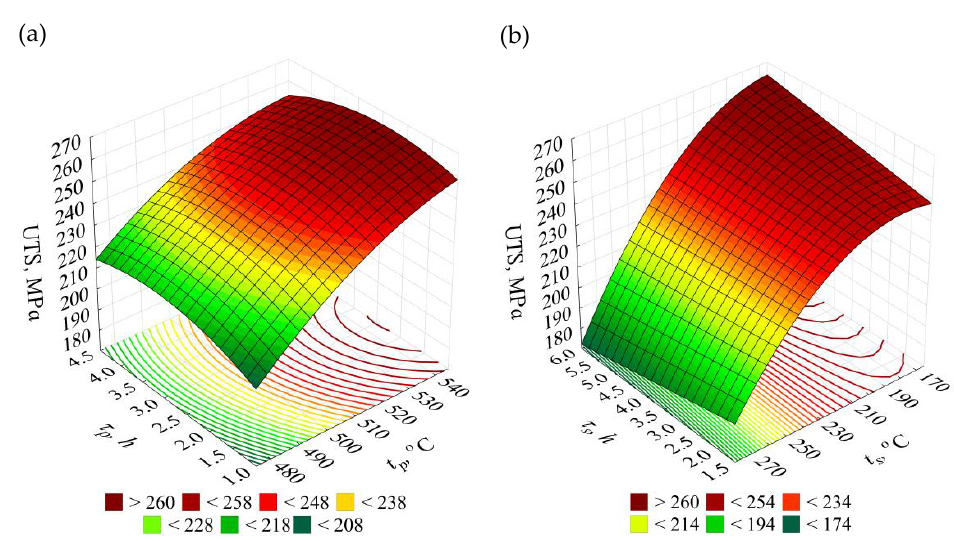
Figure 5. Effects of the T6 heat treatment parameters on tensile strength UTS of the EN AC–AlSi11(Fe) alloy for determined ( a ) t s = 165 °C, τ s = 6 h, ( b ) t p = 545 °C, τ p = 2.5 h.